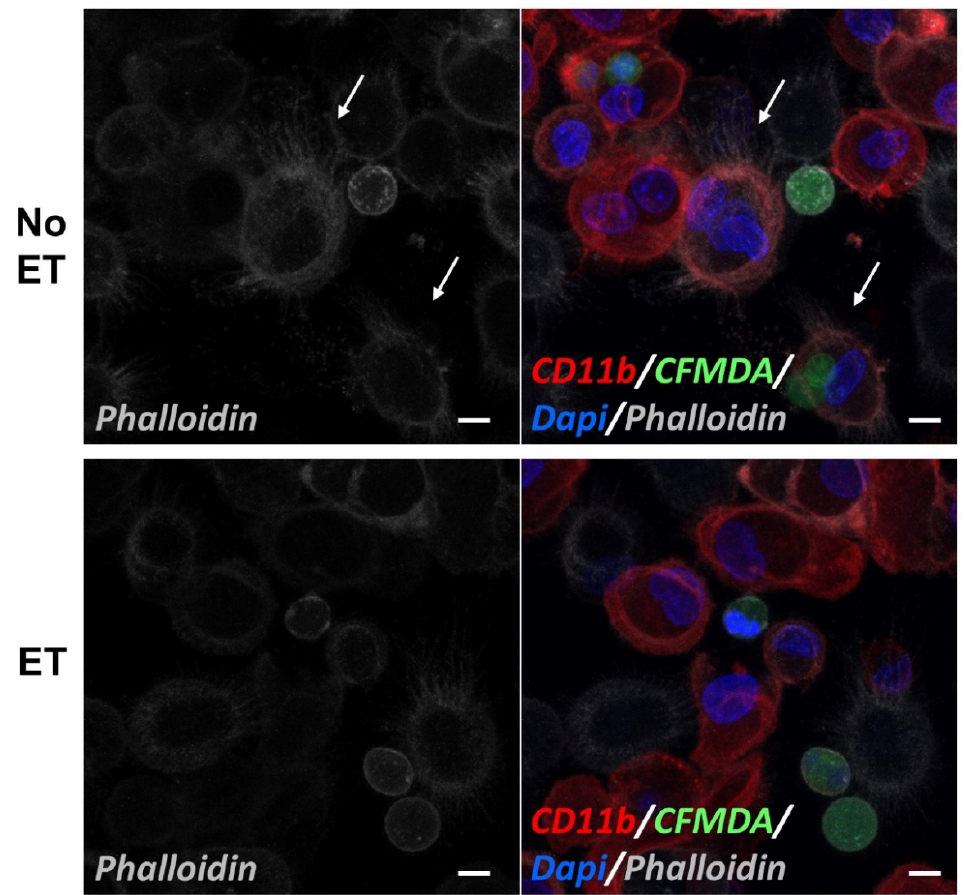
Figure 7. The lack of filopodia in ET-treated CD11b + M2(Dex) macrophages in the presence of Protein S-opsonized apoptotic PMN. M2(Dex) macrophages plated in chambered coverglass dishes were preincubated with or without 10 nM ET for 4 h and then incubated with CFMDA-labeled, Protein S-opsonized apoptotic PMN (green) for 30 min. Following the staining for CD11b with an Alexa647-labeled monoclonal antibody to detect macrophages (red), the fixed cells were stained with Alexa568-labeled Phalloidin to detect filamentous actin (gray) and with DAPI to detect cell nuclei (blue). The z-stack images collected by confocal microscopy are presented as maximal intensity projections to permit the visualization of full cell thicknesses. In the absence of ET exposure (upper panels), Phalloidin + filopodia were detected on CD11b + macrophages near CFMDA-labeled apoptotic cells (white arrows). In contrast, ET-treated CD11b + macrophages near CFMDA-labeled apoptotic cells (lower panels) lacked obvious filopodia. White bars = 10 µm.